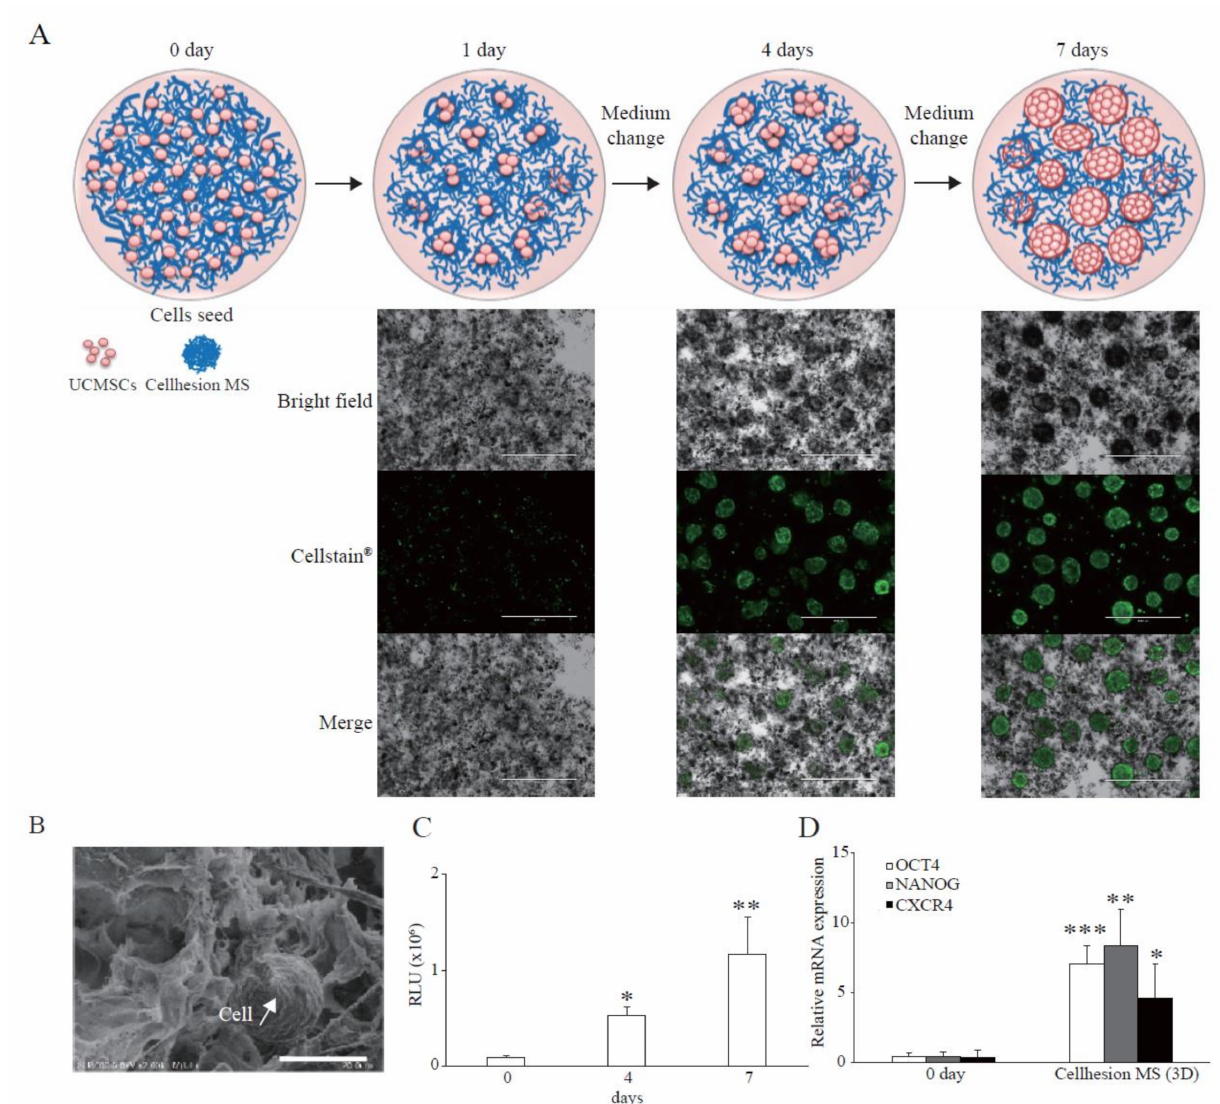
Figure 1. Features of Cellhesion ® MS culture. ( A ) Images of Cellhesion ® MS culture. Schematic representation of Cellhesion ® MS culture. Blue lines indicate Cellhesion ® MS and pink spheres indicate MSCs. UCMSCs were stained green by Cellstain ® . Scale bar = 1000 µ m. ( B ) SEM images of Cellhesion ® MS and UCMSCs. White arrows indicate UCMSCs. Scale bar = 20 µ m. ( C ) The number of UCMSCs increased in a time-dependent manner. The number of UCMSCs was measured using an ATP assay. * p < 0.05, ** p < 0.01, compared with day zero. ( D ) The expression levels of NANOG, OCT4, and CXCR4 mRNA in UCMSCs increased. The expression levels of NANOG, OCT4, and CXCR4 mRNA in UCMSCs were determined by real-time RT-PCR and normalized to GAPDH mRNA levels. * p < 0.05, ** p < 0.01, *** p < 0.001 compared with day zero. Data show mean averages ± SD for three independent